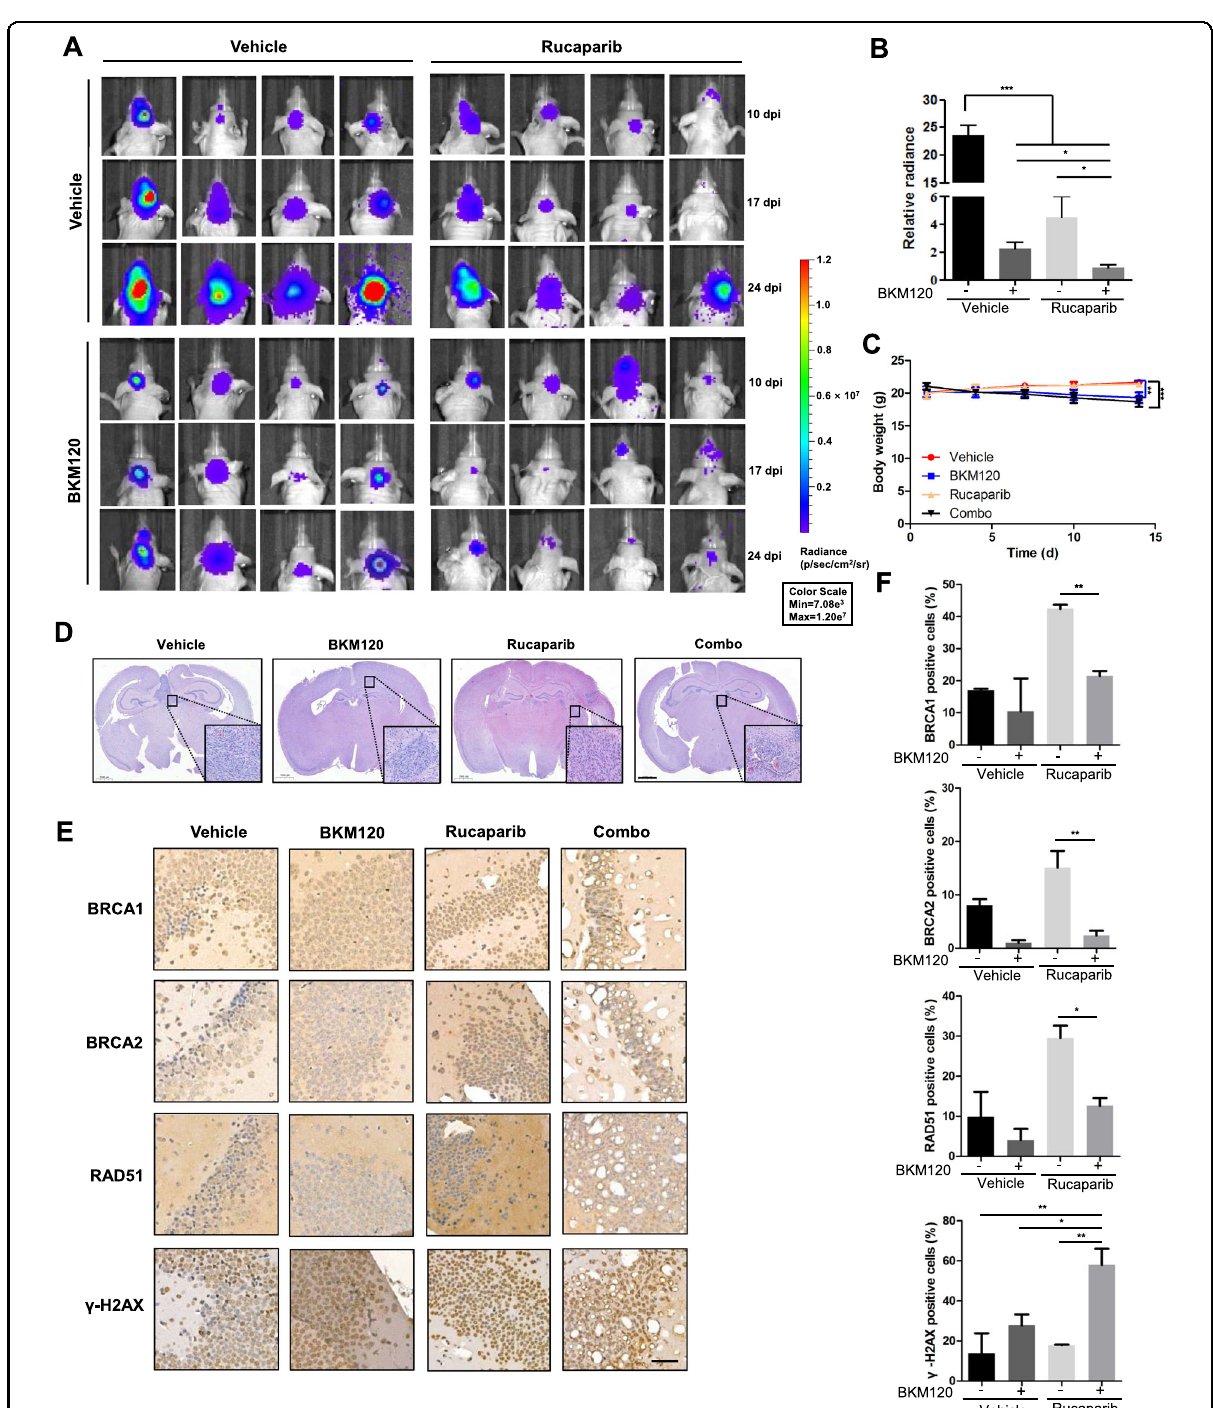
Fig. 6 BKM120/rucaparib combination treatment inhibits tumor growth in U87MG nude mouse orthotopic xenograft models. A – F Mice were inoculated with U87MG-Luc cells. The localization and intensity of luciferase expression were monitored by in vivo bioluminescence imaging (dpi, days post cell injection). Following a single dose of BKM120 (30 mg/kg) or rucaparib (10 mg/kg) or combination treatment of BKM120 and rucaparib for 14 days ( n = 5), animals were measured by a bioluminescence imaging system. A Representative images of mice taken by the bioluminescence imaging system. B The relative radiance, which represents tumor size, was determined by the imaging system. C Body weights were monitored during the 14 days of treatment. D Hematoxylin and eosin-stained section (original magni fi cation ×20) of intracranial U87MG mouse xenografts following BKM120 and/or rucaparib treatments. Scale bar: 1 mm. E Representative immunohistochemistry staining for BRCA1/2, γ -H2AX, and RAD51 in tumor tissues of U87MG xenografts. Scale bar: 50 μ m. F Statistical quanti fi cation of ( E ) shows HR repair ef fi ciency and DNA DSB levels in U87MG xenografts with the indicated treatments. Data are presented as the mean ± SD ( n = 3). * P < 0.05; ** P < 0.01; *** P < 0.001. Of fi cial journal of the Cell Death Differentiation